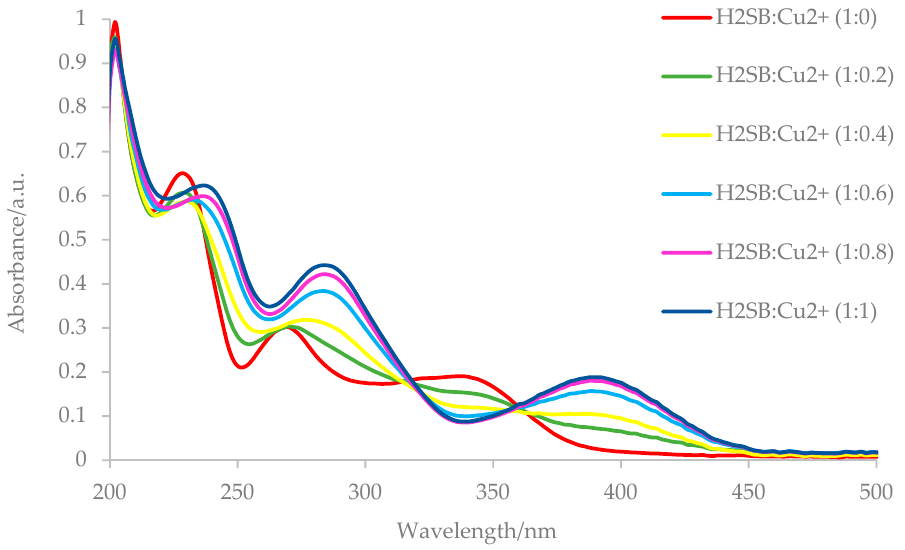
Figure 5. Partial view of the absorption spectra of H 2 SB (100 µ M,) before (red line) and after addition of Cu 2 + (100 µ M), measured in methanol-water in 80:20 v / v (pH 7.0–7.5). Spectral data were recorded immediately after the addition of Cu 2 + (0.0, 0.2, 0.4, 0.6, 0.8, and 1.0 mL) to H 2 SB (1.0 mL) at room temperature.